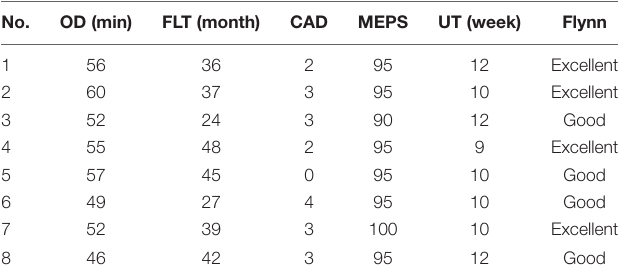
humerus are rare in children (21). A CT scan plays a significant role in the surgical plan in such a fracture